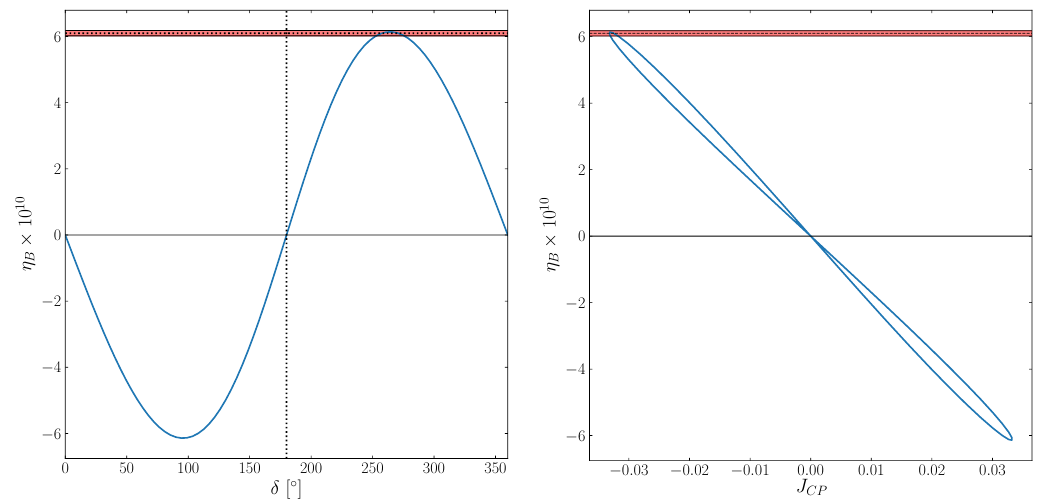
Figure 3 . The baryon asymmetry with M 1 = 5 : 13 10 10 GeV and CP violation provided solely (cid:2) by (cid:14) . The Majorana phases are (cid:12)xed at (cid:11) 21 = 180 (cid:14) and (cid:11) 31 = 0 (cid:14) . The red band indicates the 1 (cid:27) observed values for (cid:17) B with the best-(cid:12)t value indicated by the horizontal black dotted line. CMB Left: the (cid:12)nal baryon asymmetry as a function of (cid:14) with exact CP -invariance when (cid:14) = 0 (cid:14) and 180 (cid:14) (vertical black dotted line). Right: a parametric plot of (cid:17) B against J CP as (cid:14) is varied. See the text for further details.